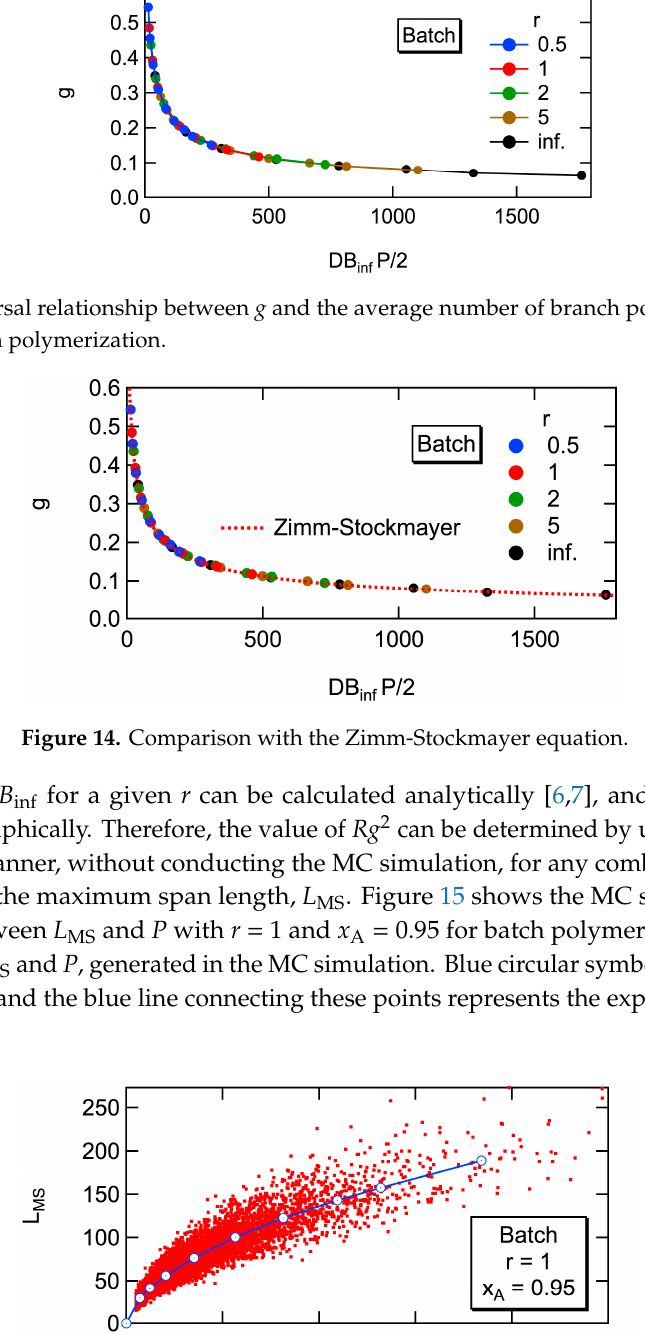
Figure 16. Relationship between L MS and P with various r -values at x A = 0.95 (filled circle), 0.9 (open circle), and 0.7 (cross) for batch polymerization.